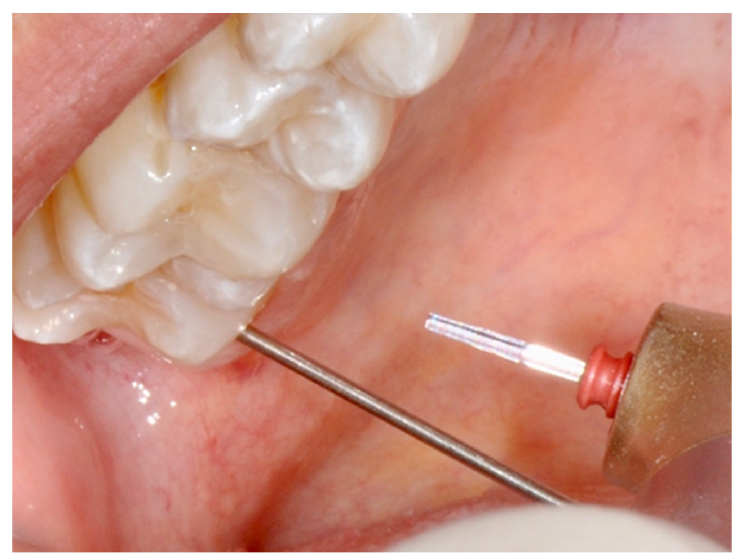
Figure 2. Example of tip kept at 10 mm for the rabbit technique of laser-induced analgesia. Irradiation at tooth neck level.